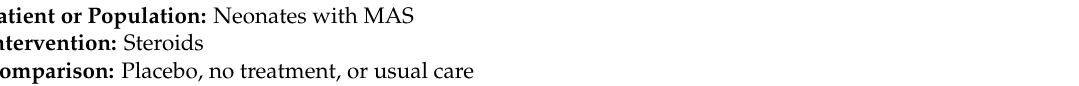
Figure 3. Forest plots of the complications and adverse effects of steroids in infants with meconium aspiration syndrome. ( A ) Meningitis; ( B ) sepsis without meningitis; ( C ) fungal infection; ( D ) oral thrush; ( E ) pneumothorax; ( F ) death. Table 2. GRADE summary of findings: Effect of steroids on clinical outcomes in neonates with MAS.